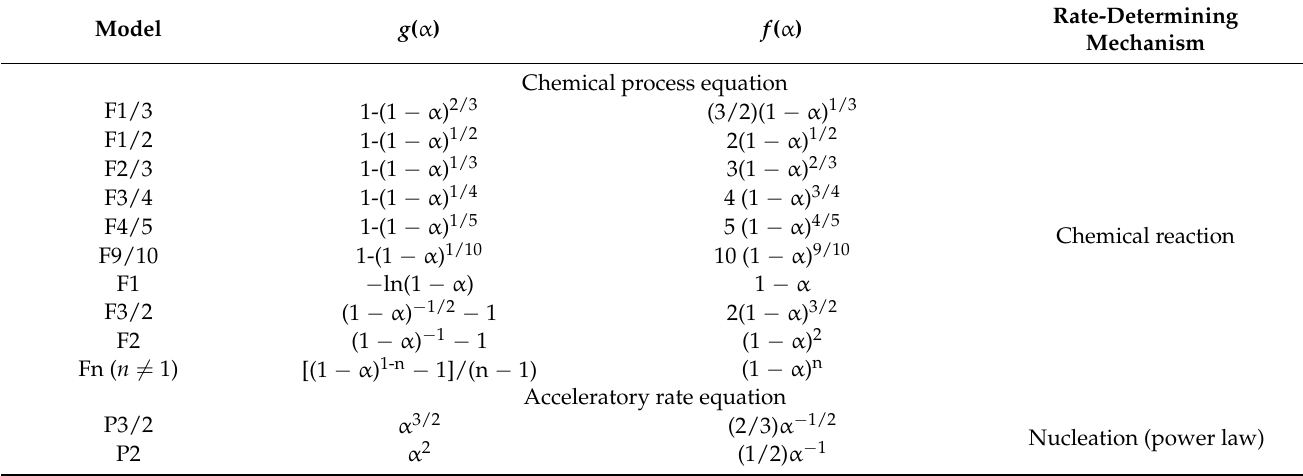
Table 1. Selected reaction models used for describing thermal degradation of nylon-6 tennis string waste.